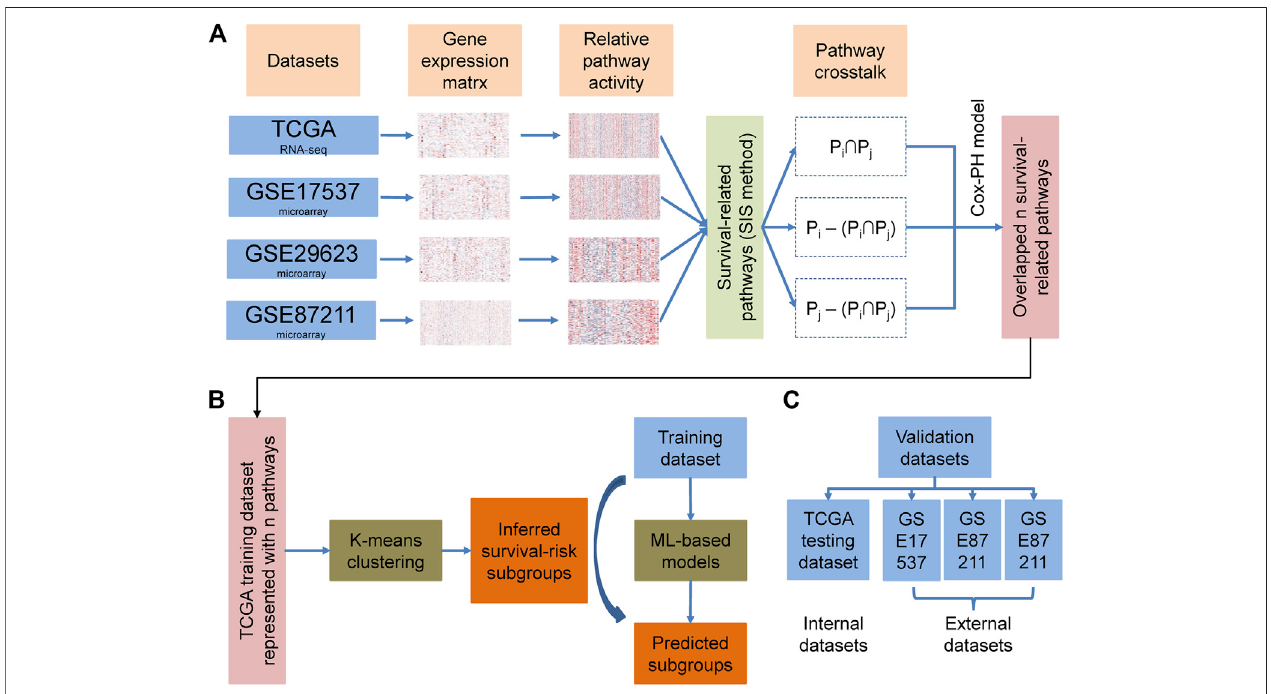
FIGURE 1 | Overall work fl ow describing the design and validation processes used in this